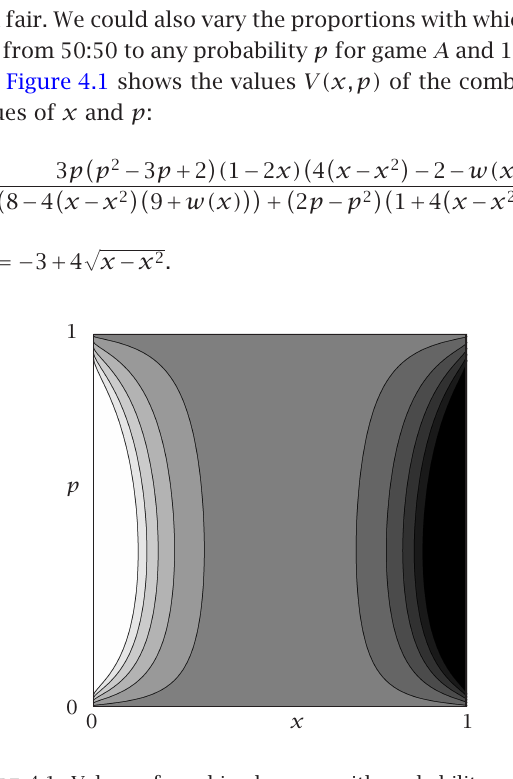
Figure 4.1 . Values of combined games with probability x of win- ning with coin 2 and probability p of playing game A (a darker shade means a smaller value). The maximum value occurs at x = 0, p = (cid:9) √ 13 − 4 1 −